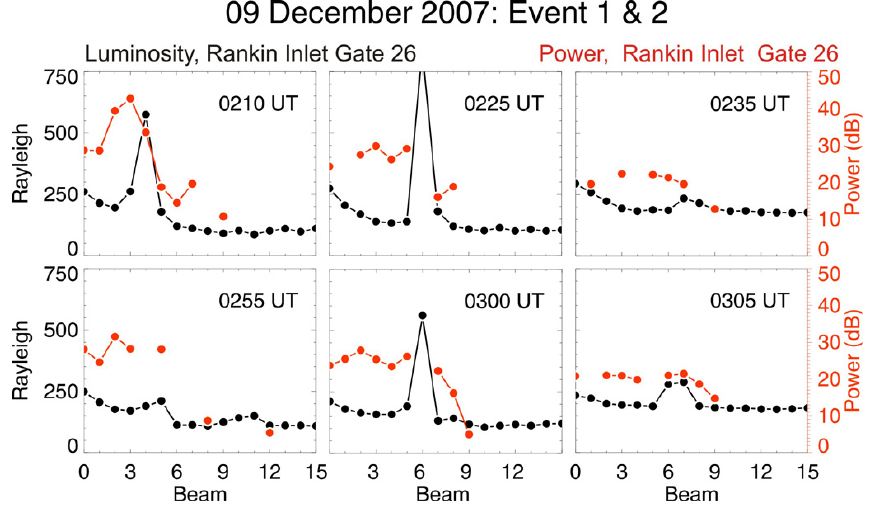
Fig. 6. A series of plots showing azimuthal distribution of the Rankin Inlet radar echo power (red) and auroral luminosity intensity (black) at the radar range gate 26. The top (bottom) sequence corresponds to event 1 (event